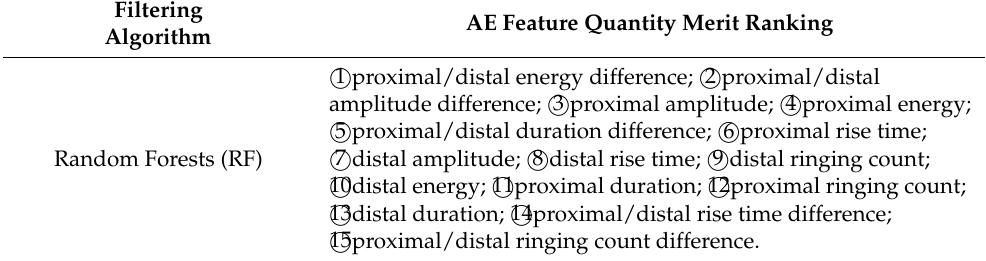
Table 7. AE feature screening